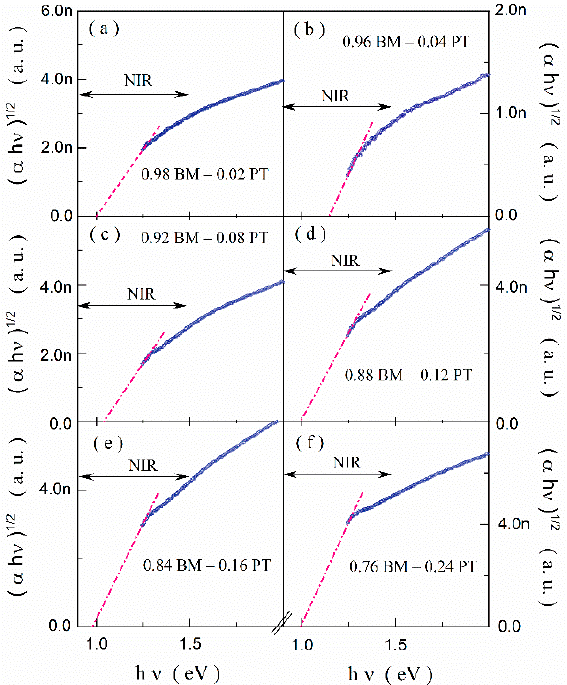
Figure 11. Modified Kubelka-Munk function ( α h ν ) 1/2 vs. photon energy h ν plot obtained for (1 − x) BM– x PT ceramics, x = 0.02, 0.04, 0.08, 0.12, 0.16, 0.24, ( a – f ), respectively.